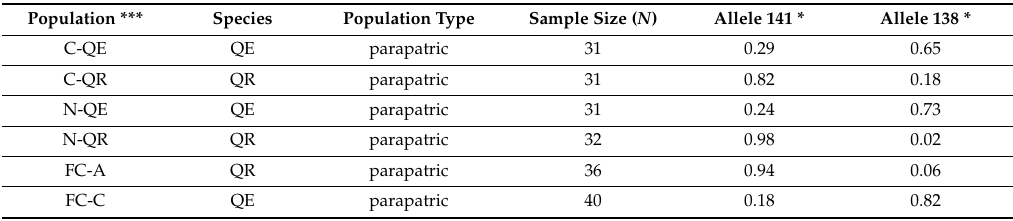
Table 2. Relative frequency of FIR013 species-specific alleles in pure Q. ellipsoidalis (QE), Q. rubra (QR), Q. velutina (QV) and Q. coccinea (QC) individuals from 15 parapatric populations and one sympatric